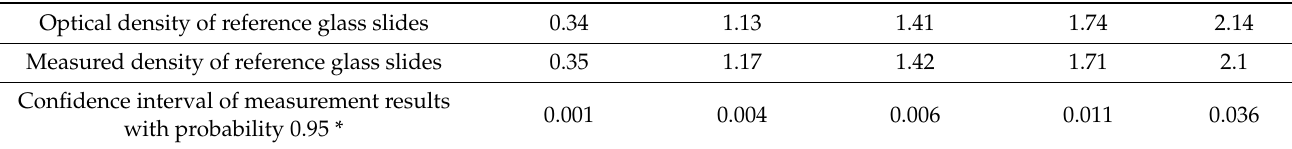
Table A1. The results of measuring the reference glass slides’ optical density by photometer which scheme is presented in Figure